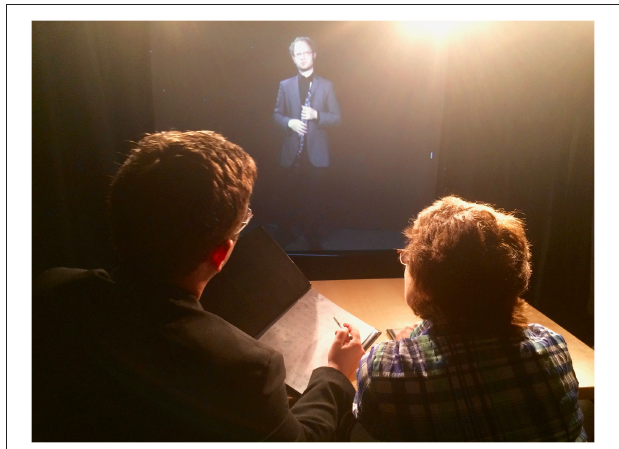
FIGURE 5 | Two evaluators delivering performance feedback in the Evaluation Simulator . Stage lights illuminate a user and a facilitator in the environment, delivering feedback to the performer in the confident feedback